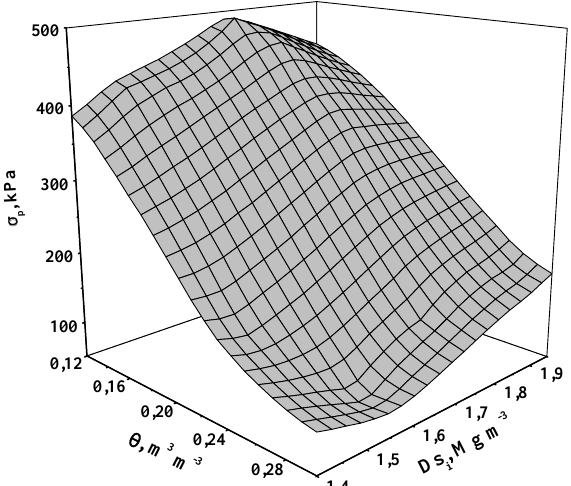
Figura 1. Variação dos valores da pressão de preconsolidação ( sssss ) com a umidade volumétrica p ( qq qq q ) e a densidade inicial do solo (Ds i